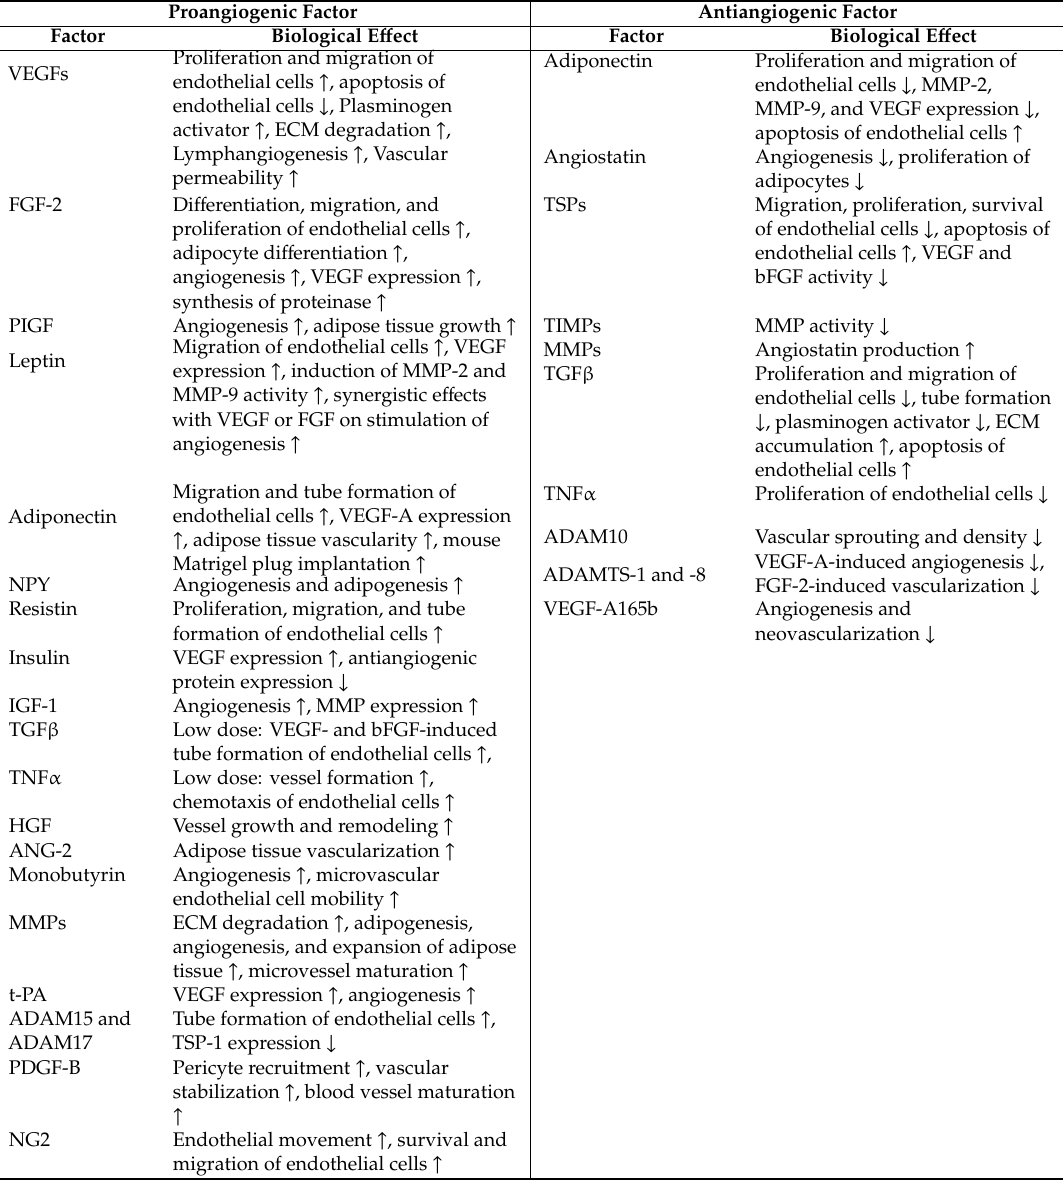
Table 1. Proangiogenic and antiangiogenic factors and their biological e ff ects on angiogenesis. Proangiogenic Factor Antiangiogenic Factor Factor Biological E ff ect Factor Biological E ff ect Proliferation and migration of Adiponectin Proliferation and migration of VEGFs endothelial cells ↑ , apoptosis of endothelial cells ↓ , MMP-2, MMP-9, and VEGF expression ↓ , apoptosis of endothelial cells ↑ Angiostatin Angiogenesis ↓ , proliferation